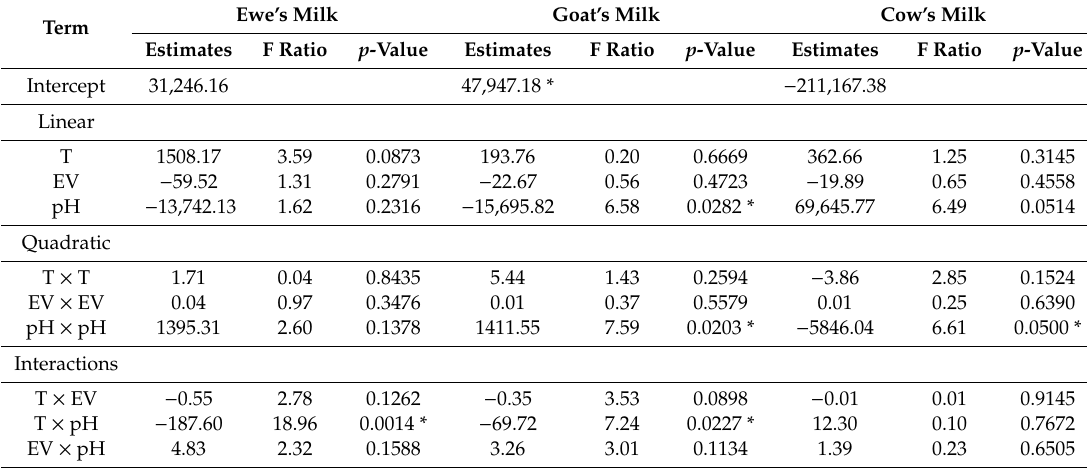
Table 3. Estimated coe ffi cients of the predicted second-order polynomial model for the milk clotting activity of commercial calf rennet.